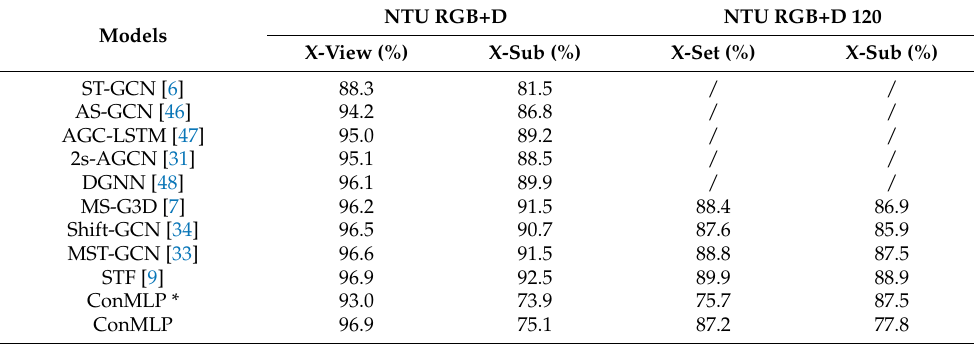
Table 3. Top 1 accuracy comparison with supervised methods.